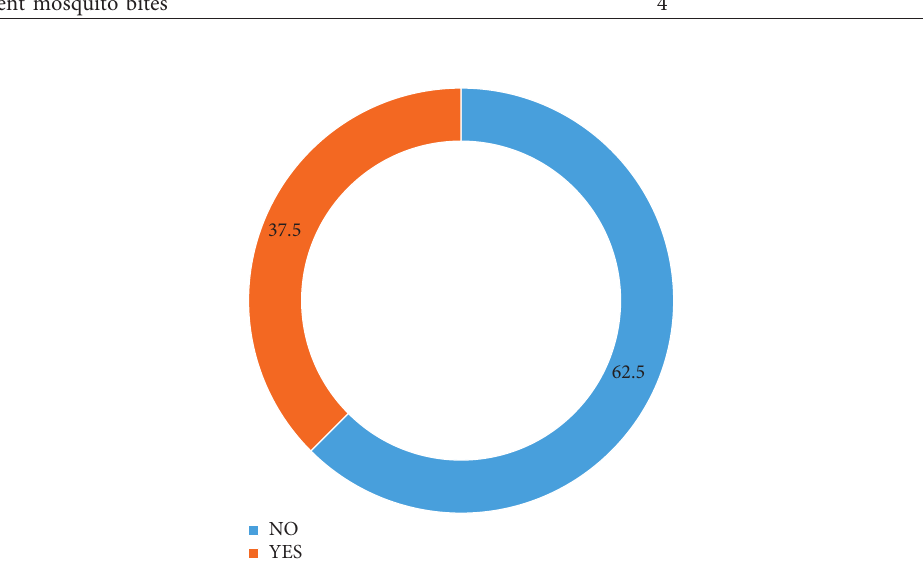
Figure 2: Pie charts showing the proportion of respondents who use LLITNs in the index